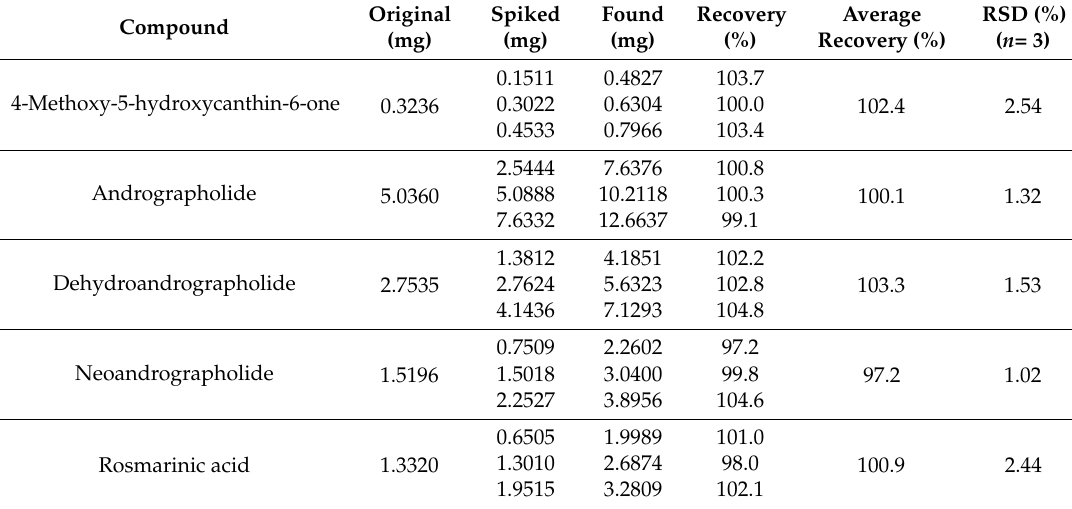
Table 3. Recovery for the analysis of the five bioactive compounds.